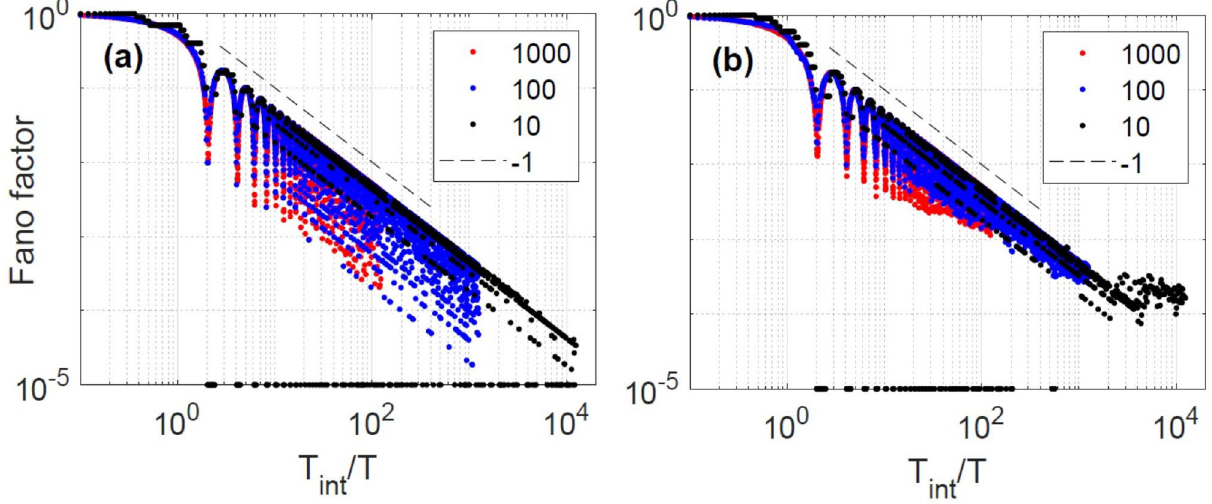
Figure 7. Fano factor of the sequence of spikes generated by sinusoidal modulation with f mod = 25 MHz and I dc = 26 mA. In ( a ) F is calculated from the original spike sequence and in ( b ) from the shuffled one, using N int = 10, 100 or 1000 spike counting intervals. To represent F = 0 in log scale, we set it to F = 10 − 5